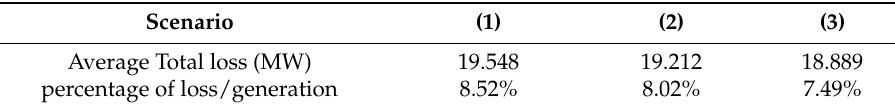
Table 2. Statistical results with three